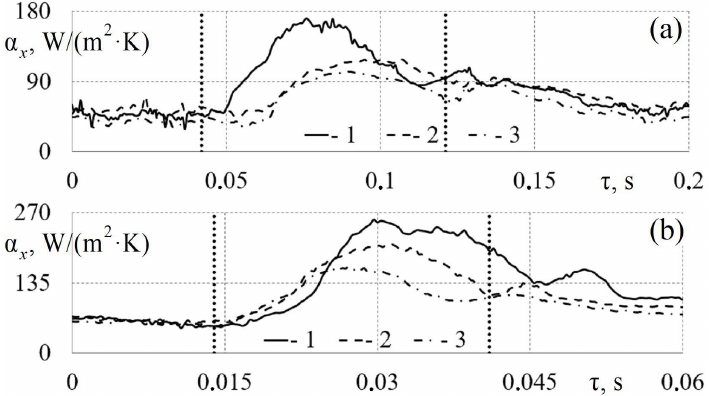
Figure 8. Dependences of the local ( l x = 100 mm) heat transfer coefficient α x in the intake system of a piston engine on time τ for crankshaft speeds of 600 rpm ( a ) and 1800 rpm ( b ) for different diameters of the intake channel: 1— d = 26 mm; 2— d = 32 mm; 3— d = 40 mm. The vertical lines indicate the opening and closing times of the intake valve.